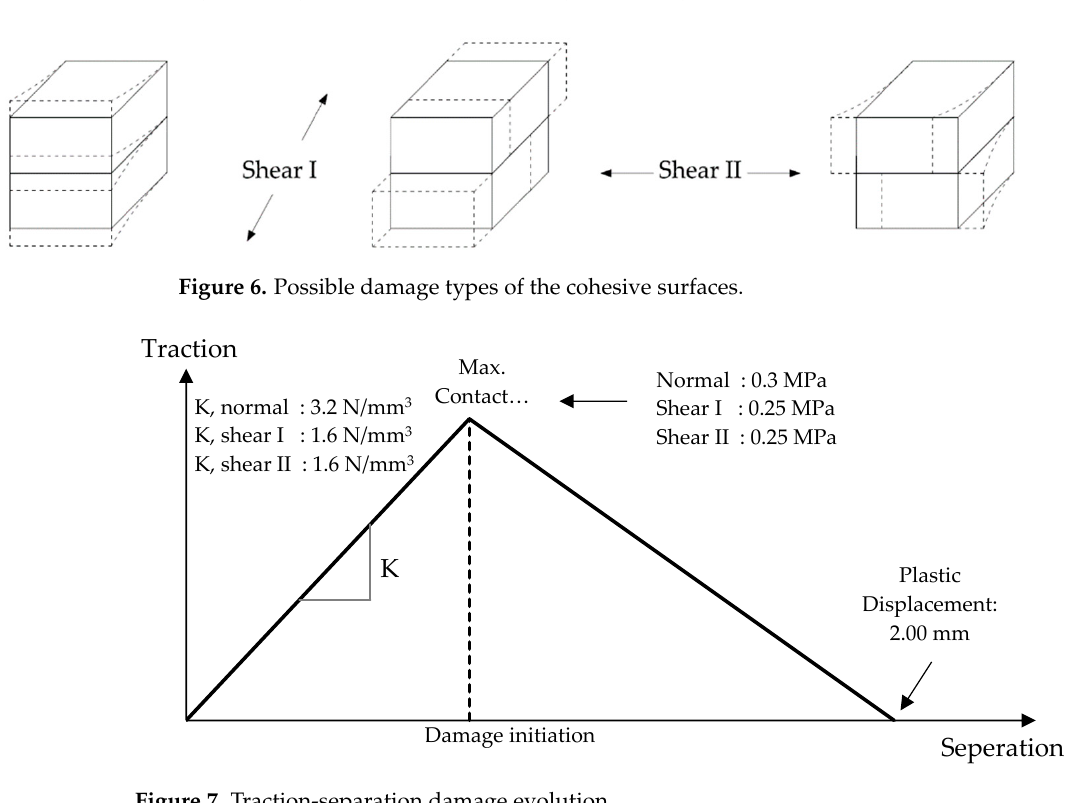
Figure 7. Traction-separation damage evolution.